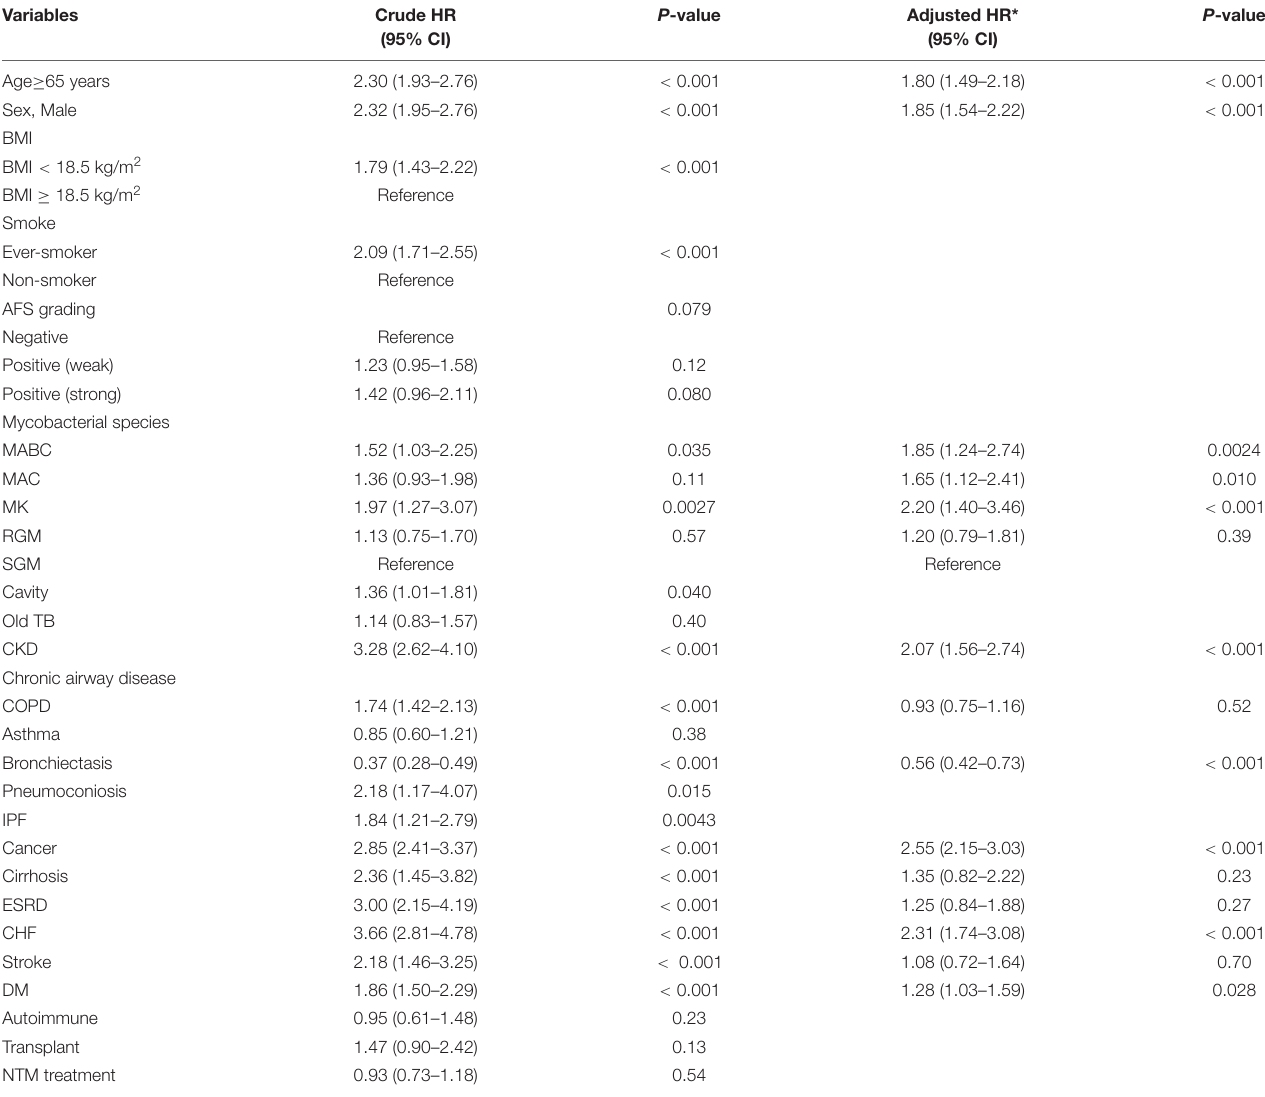
TABLE 2 | Univariable and multivariable Cox proportional hazard regression on the risk factors of NTM-LD mortality.